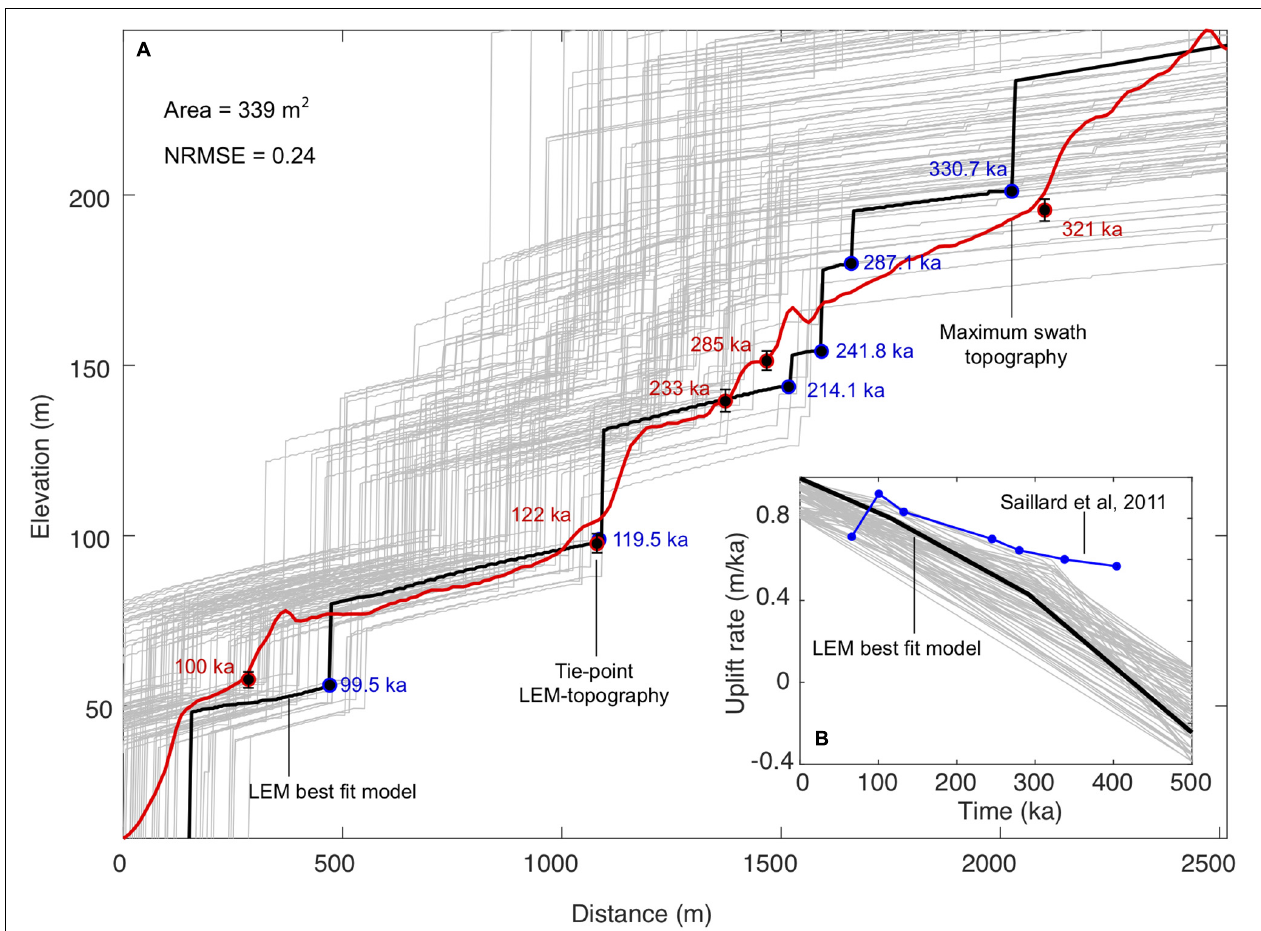
FIGURE 12 | LEM results at Cerro el Huevo. (A) Black line shows best-fit modeled topography and red line measured maximum swath topography using a TanDEM-X 12-m DEM. Gray lines show results from random-sampling modeling using 150 iterations. Blue and red numbers indicate the age of the modeled and measured shoreline angles, respectively. (B) Uplift rate histories from LEM iterations and from Saillard et al. (2011). Black line shows best-fit model. The minimized area between model and topography and the Normalized Root Mean Squared Error (NRMSE) of the best fit model are indicted in the upper left